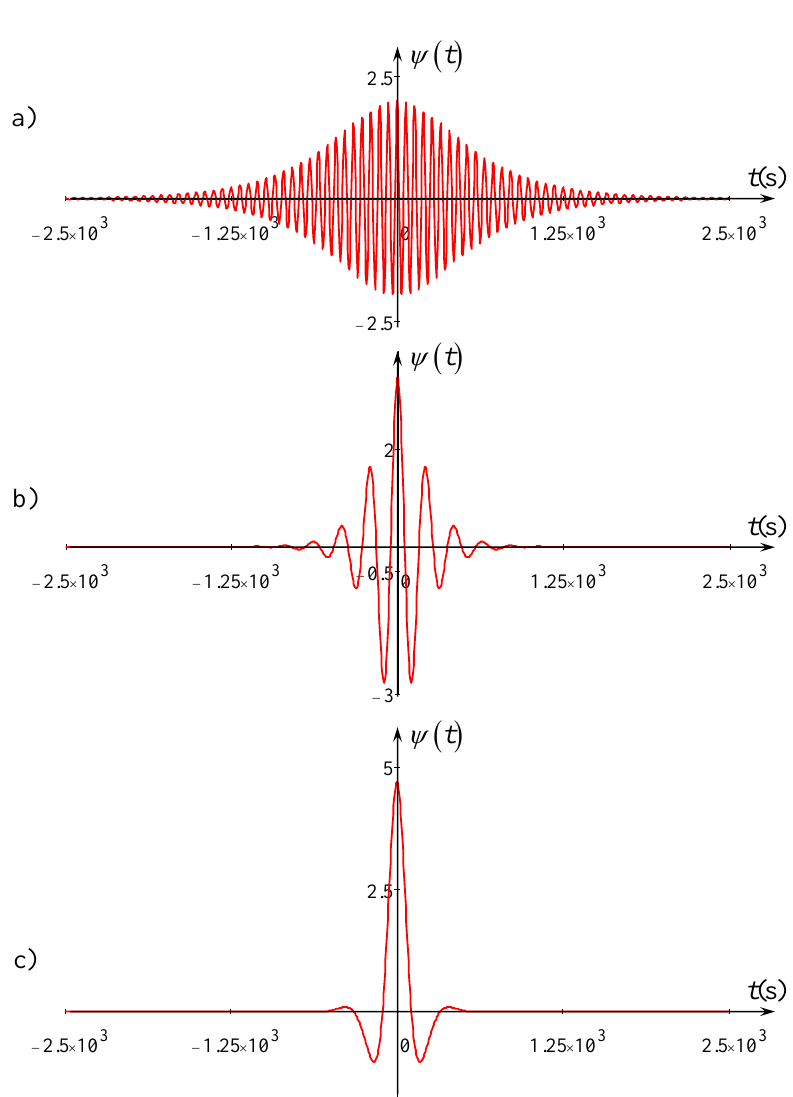
Figure 3. (Color online) An NLS envelope soliton of Equation (10) at x = 0 (frame ( a )), x = 0.5 L (frame ( b )), and x = 0.7 L (frame ( c